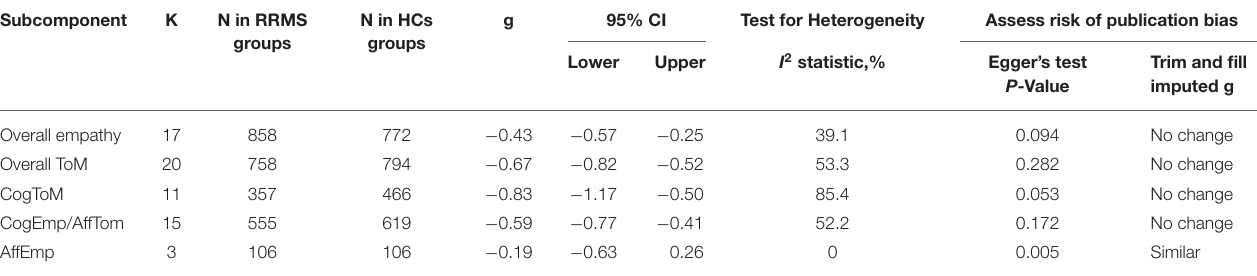
TABLE 4 | Mean effects for ToM and empathy subcomponents comparing participants with relapsing-remitting multiple sclerosis against healthy controls and tests for publication bias. Subcomponent